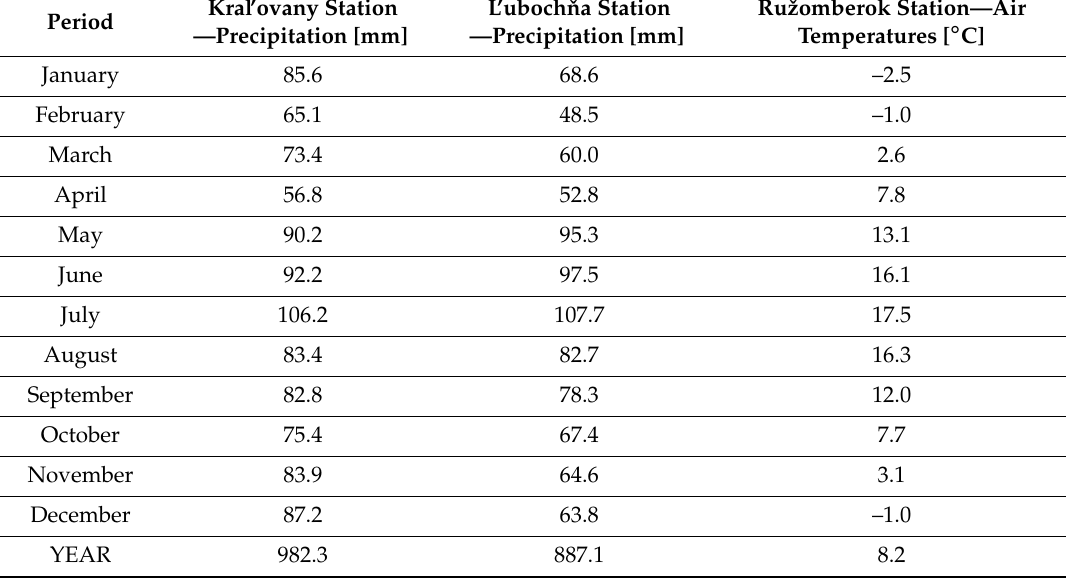
Table 3. Mean annual and monthly values of precipitation totals and mean air temperatures at precipitation stations Kral’ovany and L’ubochˇna, and climatic station Ružomberok for the period of